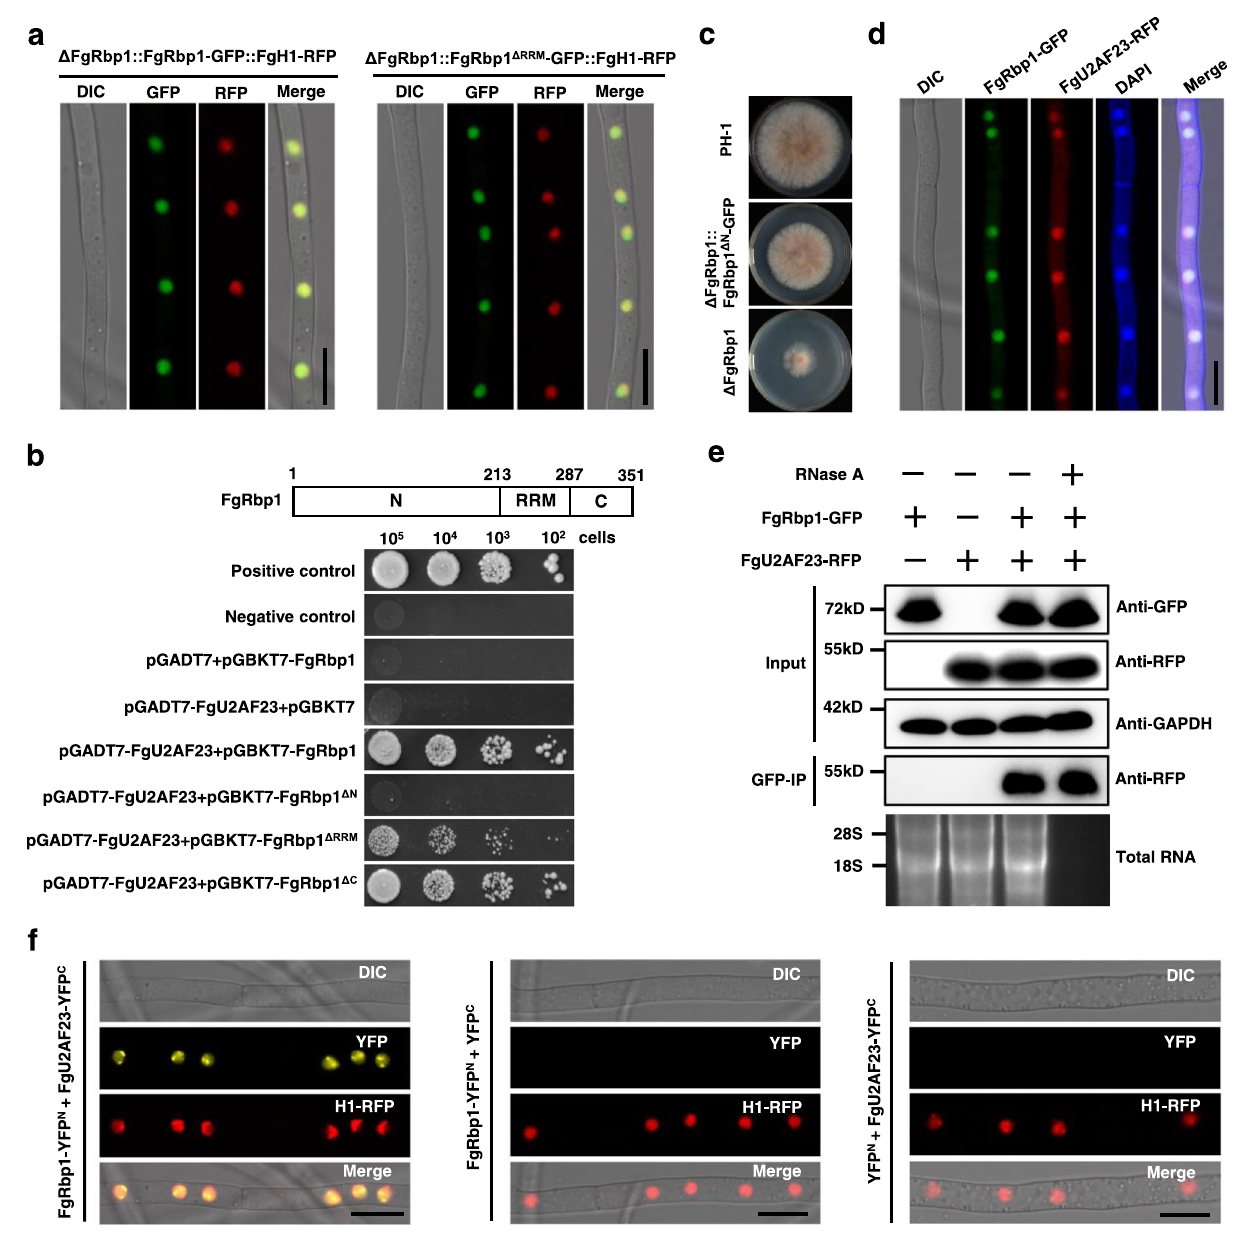
Fig. 2 Nuclear localization of FgRbp1 and its physical interaction with the splicing factor FgU2AF23. a Subcellular localization of FgRbp1 (left panel) and FgRbp1 Δ RRM (right panel) in F. graminearum . Both FgRbp1-GFP and FgRbp1 Δ RRM -GFP localize to the nucleus and co-localize with the RFP-tagged histone H1. Bar = 10 µ m. b Yeast two hybrid assay veri fi es interaction of FgRbp1 with FgU2AF23, demonstrating the essential role of the N-terminal domain of FgRbp1 in the interaction. The domain arrangement within FgRbp1 and the number of amino acids of corresponding domains are depicted in the schematic at the top. Tenfold serial dilutions of yeast cells transferred with the bait (a series of truncated FgRbp1) and prey construct (pGADT7-FgU2AF23) were assayed for growth on SD-Leu-Trp-His-Ade plates. A pair of plasmids, pGBKT7-53 and pGADT7-T was used as the positive control, while pGBKT7-Lam and pGADT7-T was used as the negative control. c Colony morphology of PH-1, Δ FgRbp1, and Δ FgRbp1::FgRbp1 Δ N -GFP on PDA at 25 °C for 3 d. d FgRbp1-GFP co-localizes with FgU2AF23-RFP in the nucleus. Nuclei in hyphae were stained with 4 ’ ,6-diamidino-2-phenylindole (DAPI). Bar = 10 µ m. e The interaction between FgRbp1 and FgU2AF23 is con fi rmed by co-immunoprecipitation assay. The sensitivity of the interaction to RNase A was determined by treating the lysates with RNase A prior and during immunoprecipitation. To assess RNase A treatment ef fi ciency, the RNA from the 1/10 volume lysate of each strain was extracted with Trizol reagent after immunoprecipitation and assessed on the agarose gel. f Bimolecular fl uorescence complementation (BiFC) analysis veri fi es the FgRbp1-FgU2AF23 interaction in vivo. Transformants with FgRbp1-YFP N and FgU2AF23-YFP C constructs were examined under the confocal microscope. The strains bearing a single construct (FgRbp1-YFP N or FgU2AF23-YFP C ) were used as negative controls. The RFP-tagged histone H1 was used to visualize the nucleus. Bar = 10 µ